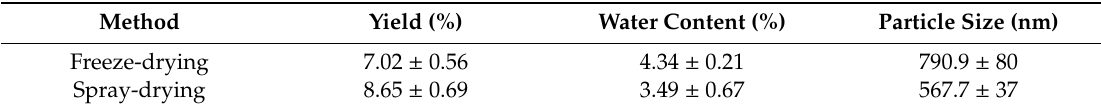
Table 3. E ff ect of drying method on inulin.